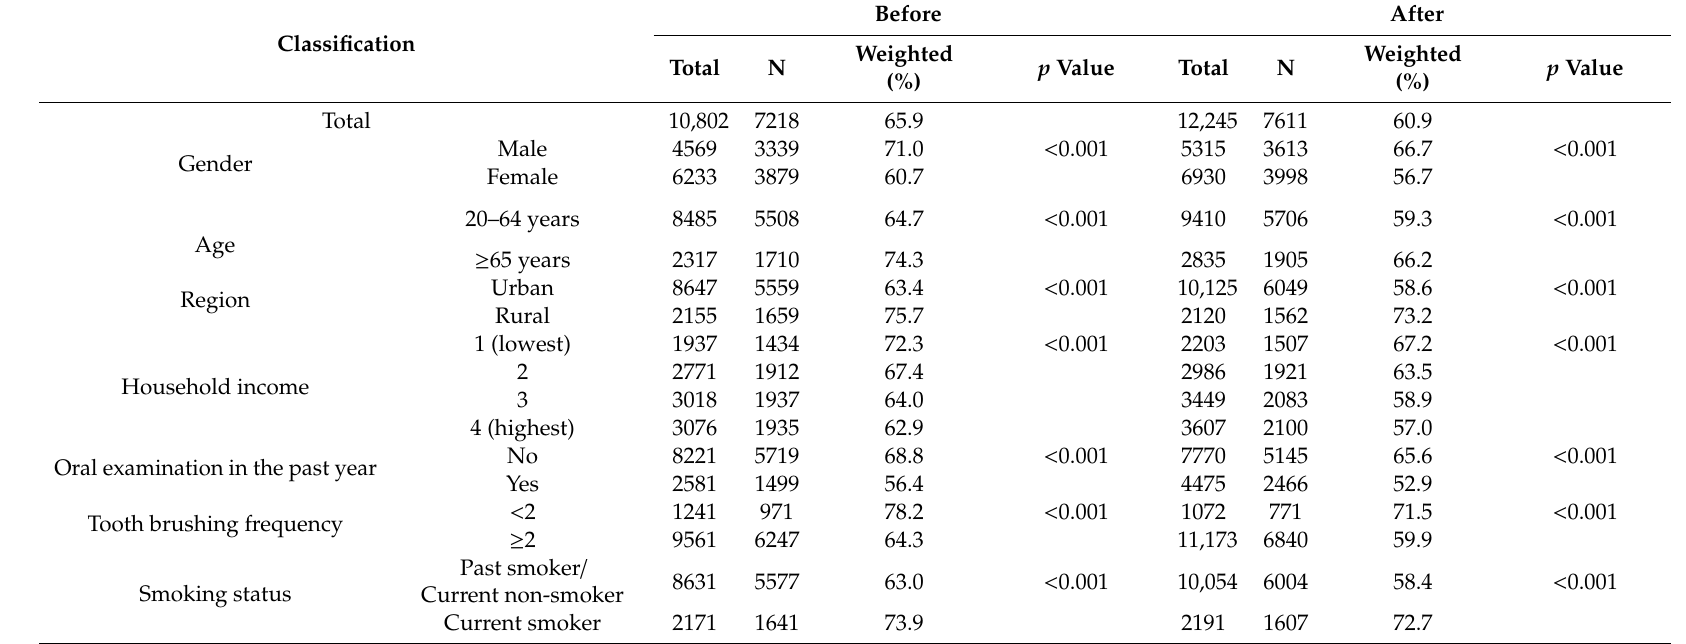
Table 3. Changes in the prevalence of need for scaling according to health insurance coverage for dental